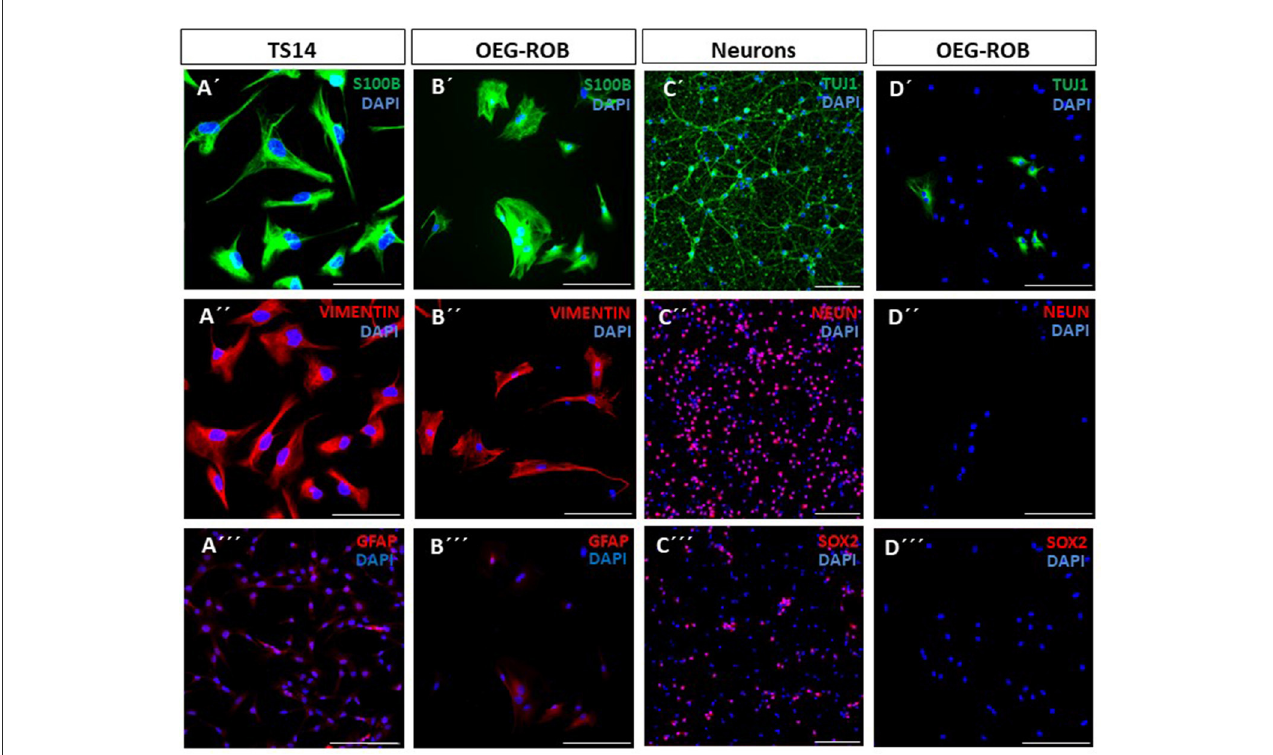
FIGURE1 Characterization of OEG-ROB cells. Expression analysis of glial and neuronal markers was performed by immunofluorescence in primary cultures of rat olfactory bulb ensheathing glia (OEG-ROB); TS14 immortalized OEG line and a neuronal primary culture from rat embryonic cortex (E18) were used as positive controls. Glial markers S100 β (green) and vimentin (red) were expressed in TS14 (A ′ , A ′′ ) and OEG-ROB (B ′ , B ′′ ) , while GFAP (red) was also expressed in both OEG cell types (A ′′′ , B ′′′ ) but with a more diffused pattern. Proneural gene NeuN expression (red) was absent from OEG-ROB, while neuronal culture stained positively for this marker (C ′′ , D ′′ ) . However, Tuj1 (green) not only stained embryonic neurons, but was also detected in OEG-ROB (C ′ , D ′ ) . OEG-ROB population was not contaminated with neural precursors as SOX2 positive staining (red) was not detected in the OEG-ROB culture, while neural progenitor cells from rat embryonic cortex expressed this neural precursor marker (C ′′′ , D ′′′ ) . Nuclei were stained with DAPI (blue). For quantitative data, see Supplementary Figure 1. Scale bar: 100 µ m.